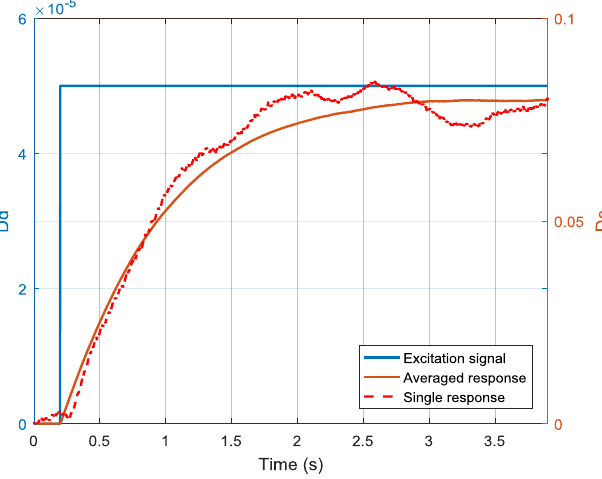
Figure 8. Excitation signal and responses of step experiments.